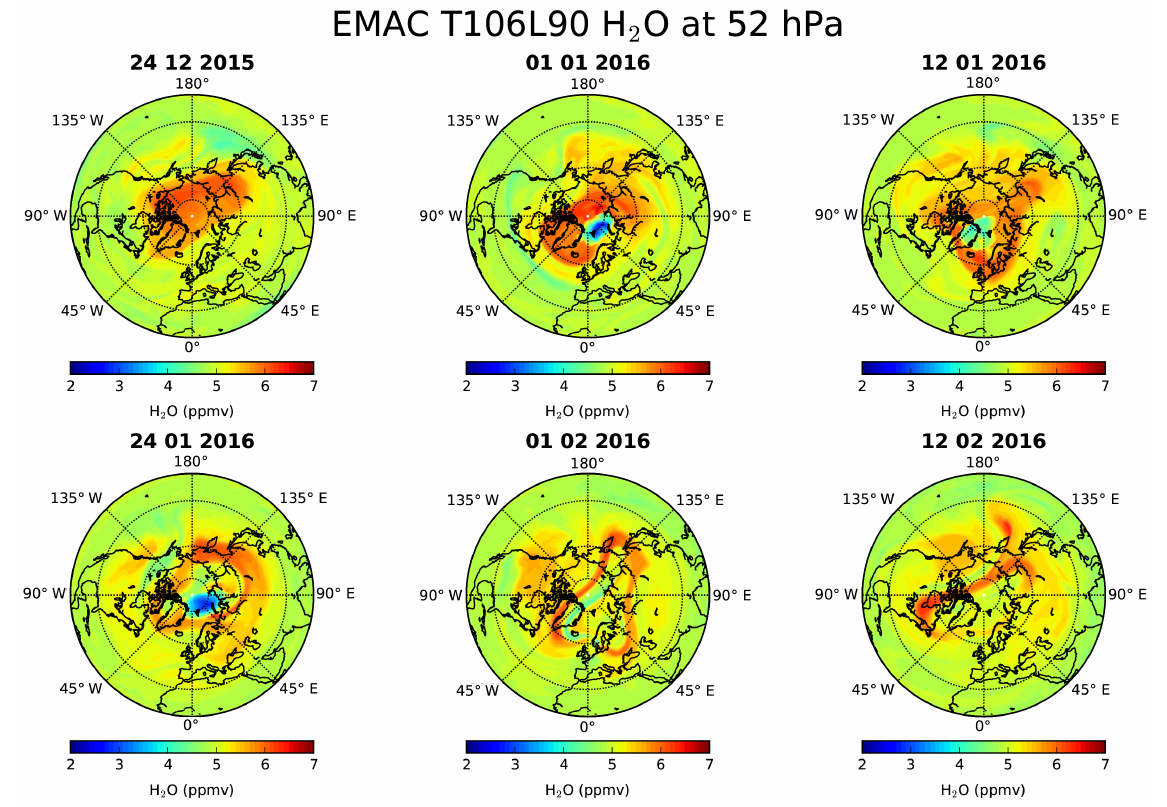
Figure 5. Distribution of H 2 O as simulated with EMAC T106L90 at 52hPa on certain dates between 24 December 2015 and 12 Febru- ary 2016.